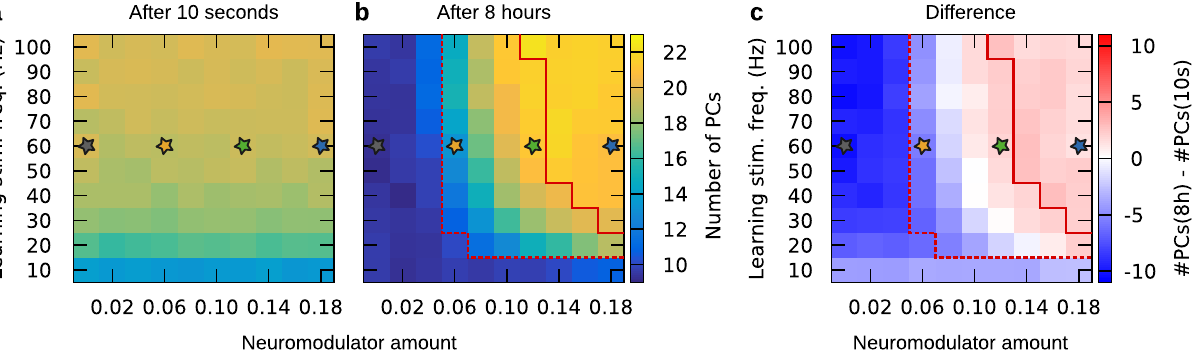
Figure 5. Moderate to high level of neuromodulation during consolidation is required to increase or maintain dimensionality of neuronal activity upon 8 h recall. Number of principal components (PCs) required to explain 70% of variance in 1 ms-binned spike data during ( a ) 10 s recall and ( b ) 8 h recall. ( c ) The difference between 10 s recall and 8 h recall. Data were averaged over 50 networks ( a , b ) before being subtracted ( c ). For statistical analysis see main